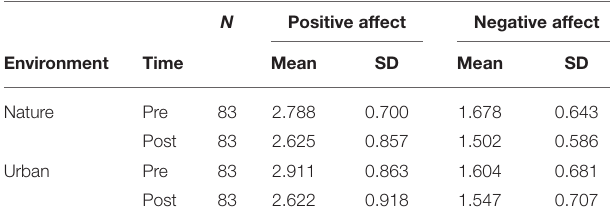
TABLE 9 | Descriptive statistics for Positive and Negative Affect, for study samples with environment as a between-subjects